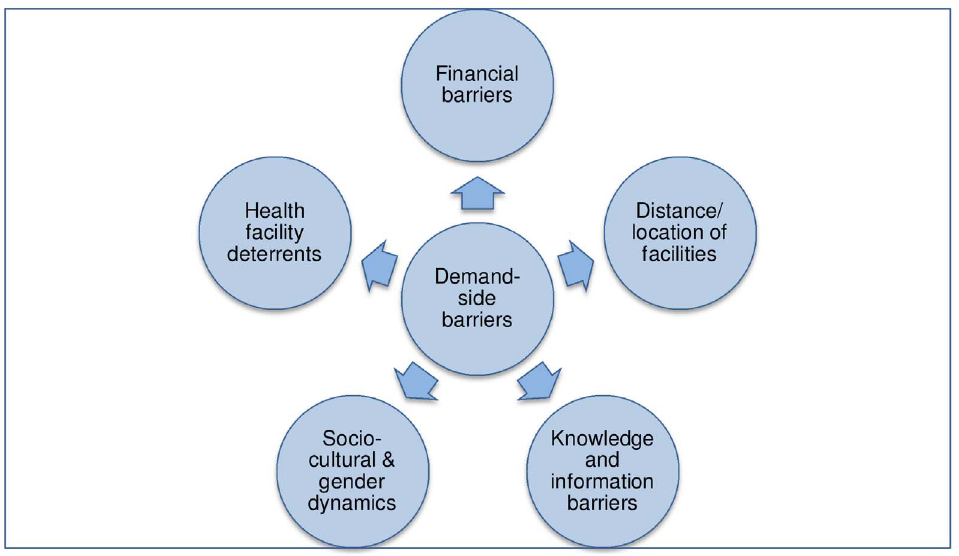
Figure 4. Demand-side barriers identified by participants in all three settings.